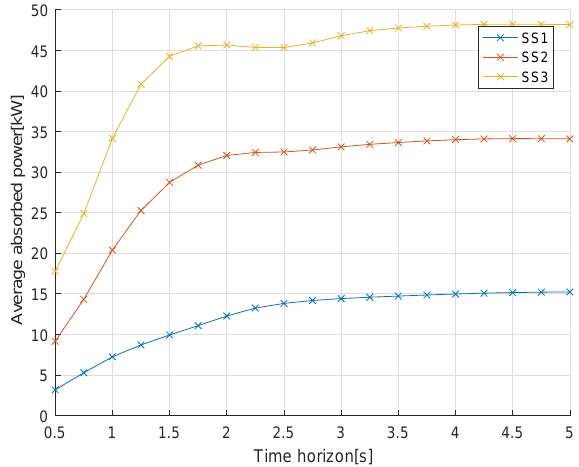
Figure 9. Average absorbed power versus prediction horizon for a 25 ms time step for three sea states.